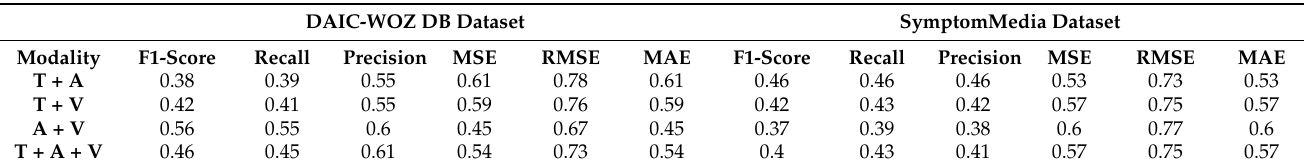
Table 5. The performance and error metrics for the SVM + RF with SVM late fusion (T + A: text